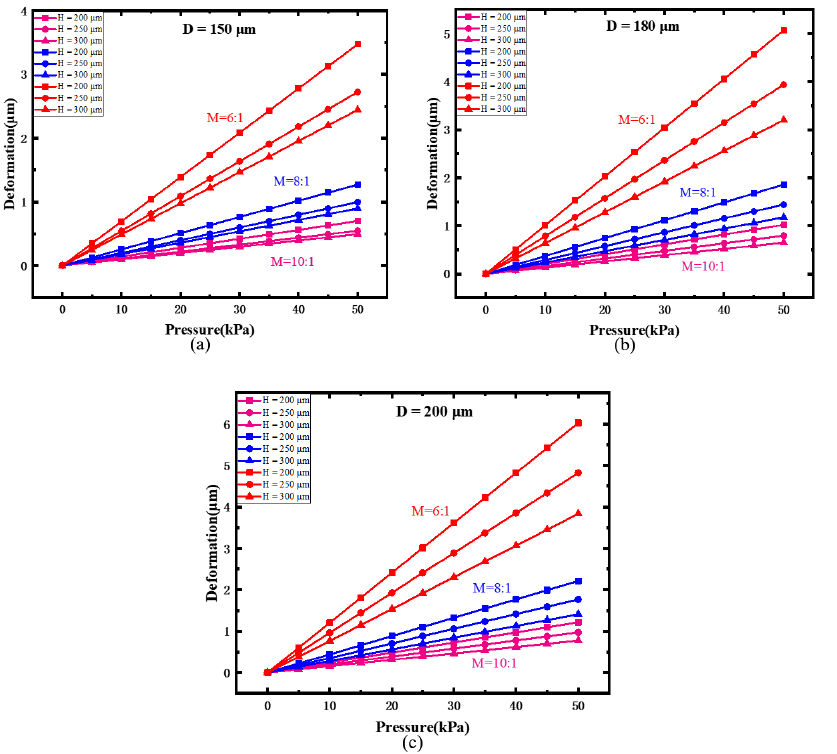
Figure 6. Relationship between the pressure and deformation: ( a ) diameter of 150 μ m, ( b ) diameter of 180 μ m, and ( c ) diameter of 200 μ m.